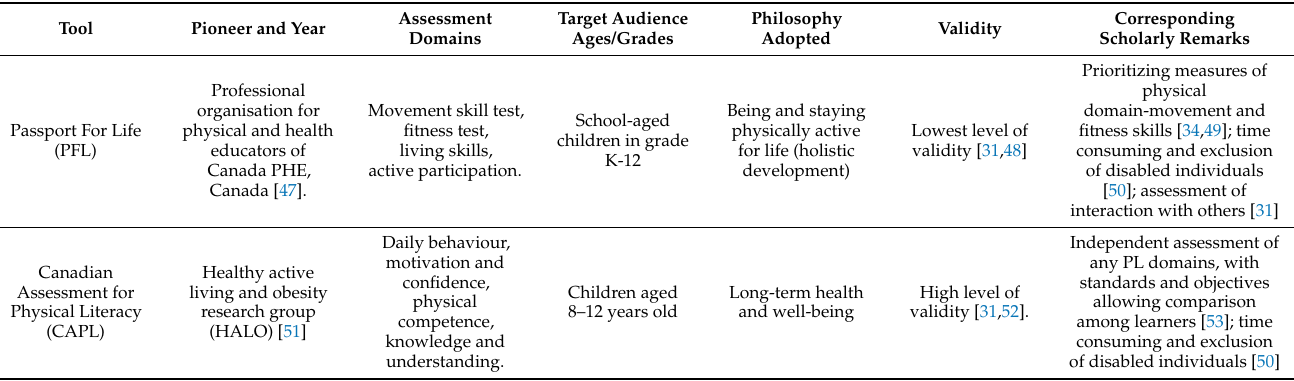
Table 1. Physical literacy assessment